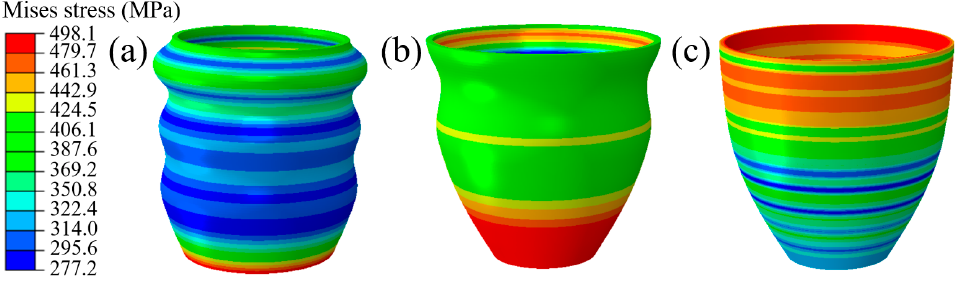
Figure 20. Mises stress distribution of formed parts using TUBG. ( a ) The first stage of TUBG, ( b ) The shape of the nozzle that two wrinkles are flattened, ( c ) A well-formed rocket nozzle. In order to explore the accuracy of the forming zone, the upper and lower limits of the forming zone are taken respectively. As shown in Figure 21a–c, when P = 13.9 MPa, the evolution process of tube bulging is discussed. With the increase of internal pressure, the wrinkles are flattened to a certain extent. Finally, after forming, the tube was perfectly molded.